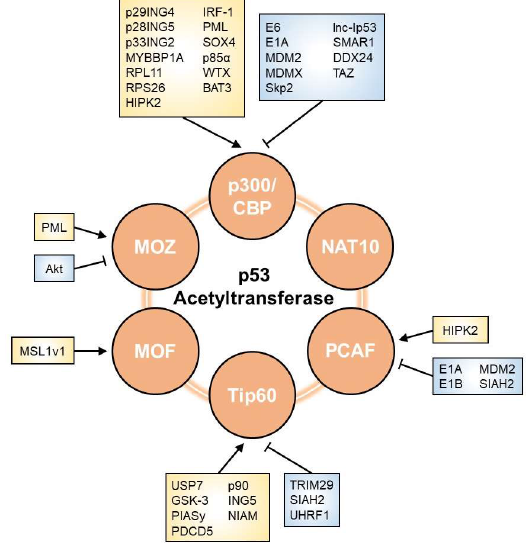
Figure 2. Regulators of p53 acetyltransferase. The acetyltransferase activity towards p53 is affected by various factors, including viral oncoproteins, E3 ubiquitin ligases, phosphatases, lncRNAs, and other proteins. Arrows and perpendicular bars indicate enhancing and suppressive effects towards p53 acetyltransferases,